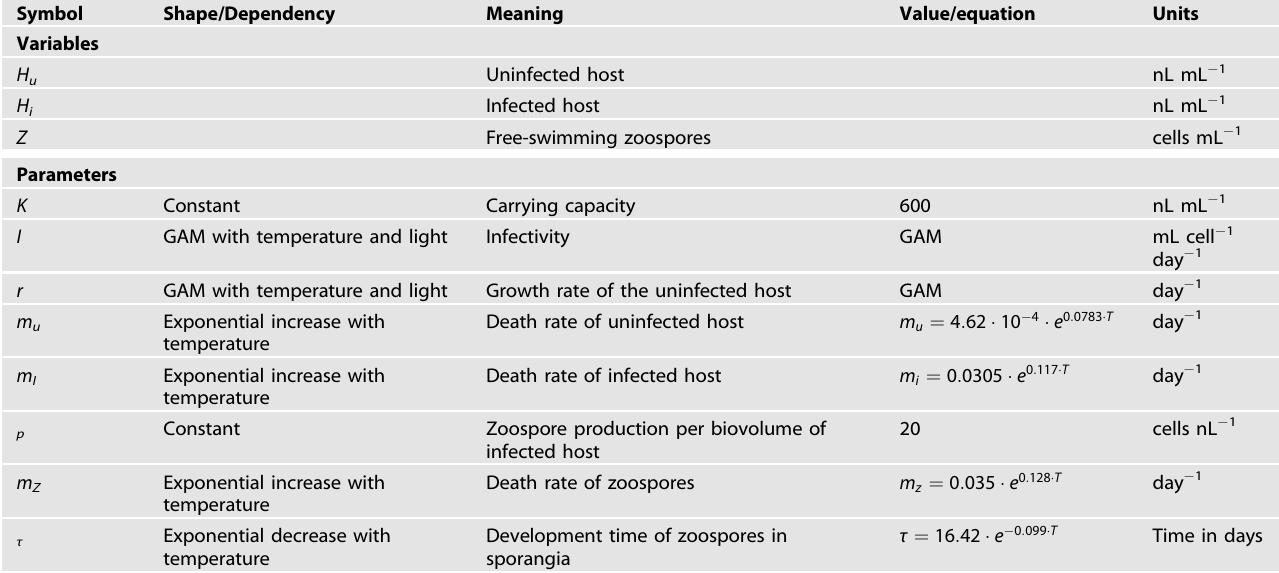
Table 1. Overview of all parameters and variables used in the dynamical